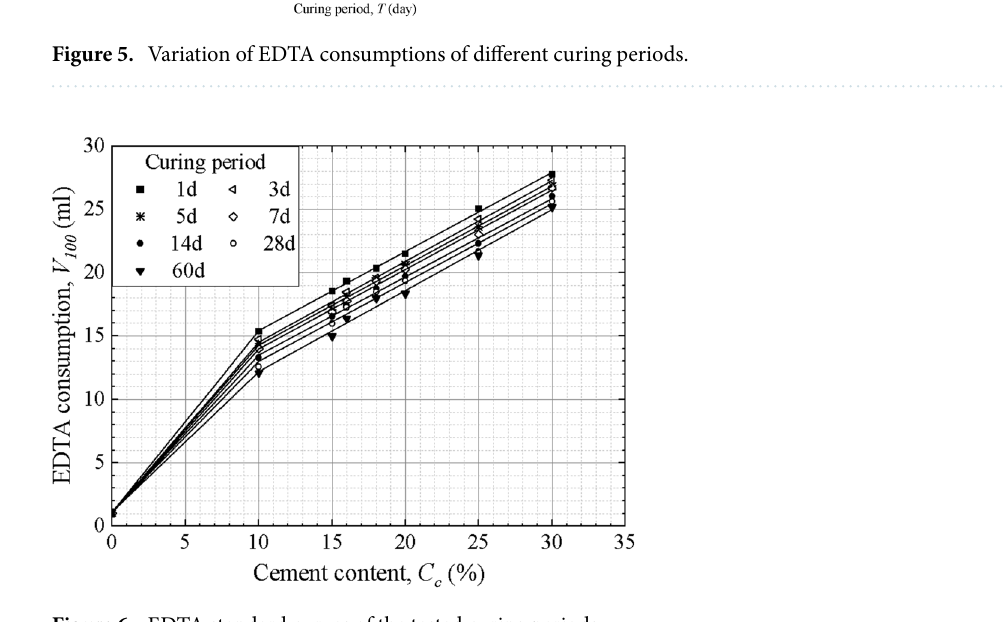
Figure 6. EDTA standard curves of the tested curing